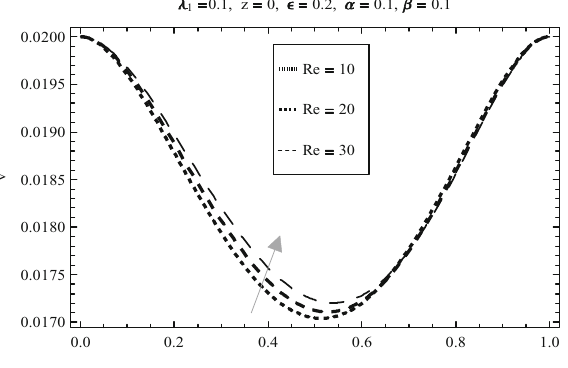
Fig. 9 Velocity component v along y for different values of Re